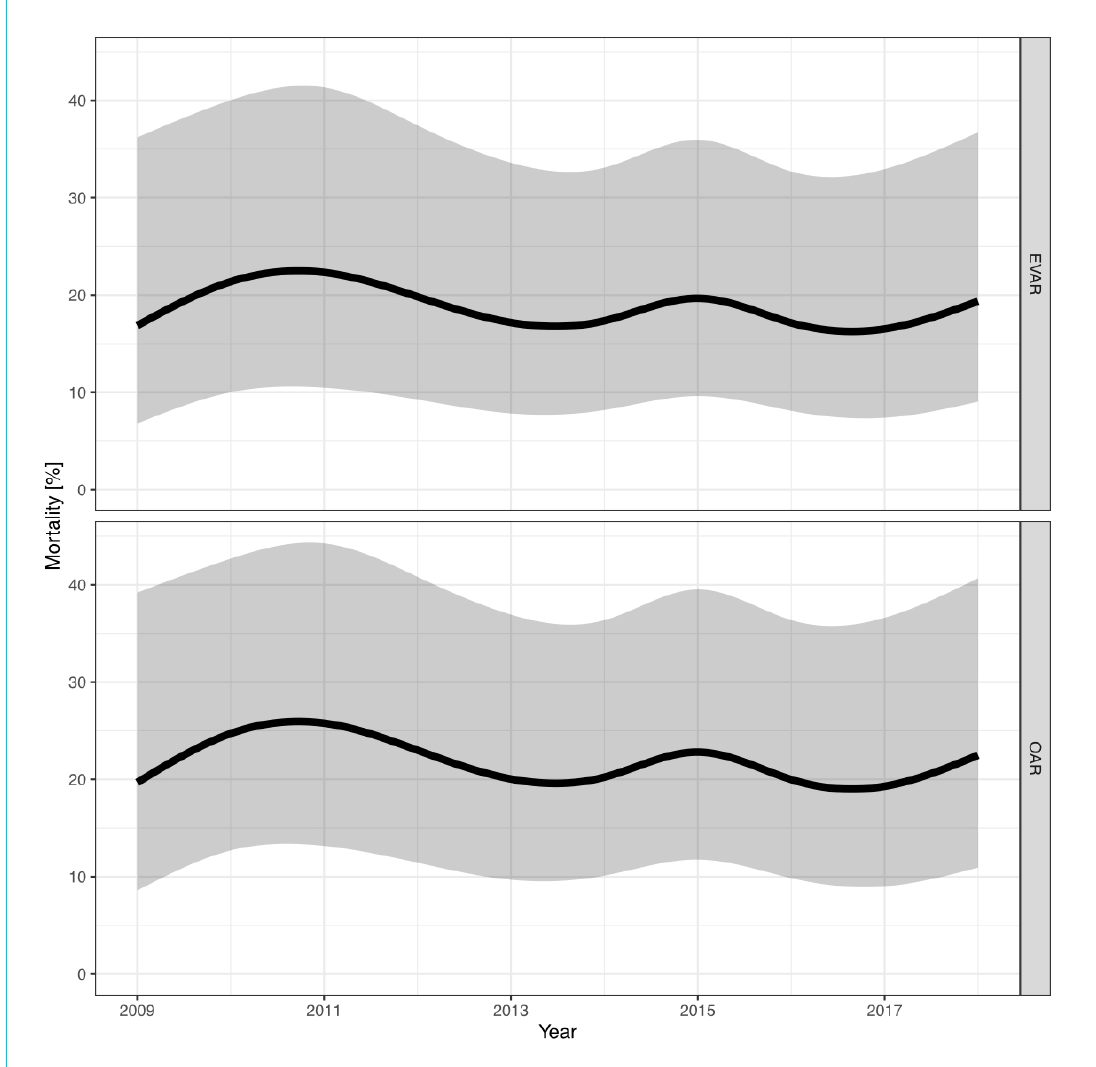
Figure S3: Hospital mortality of patients treated for ruptured abdominal aortic aneurysm (rAAA) stratified by treatment. Smoothed adjusted hospital mortality rates with 95% confidence interval of patients treated for rAAA stratified by treatment. Adjustments were made for age,